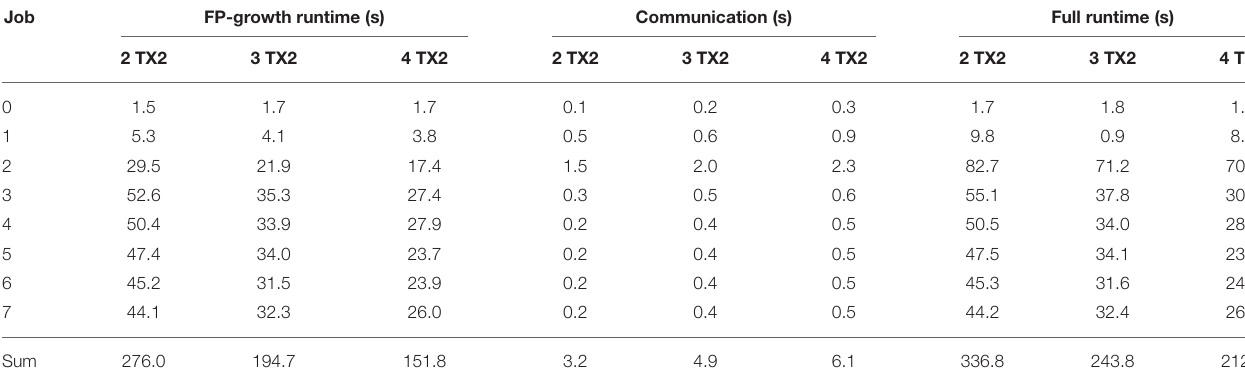
TABLE 6 | Runtime of the multi-threaded implementation on up to four NVIDIA Jetson TX2.